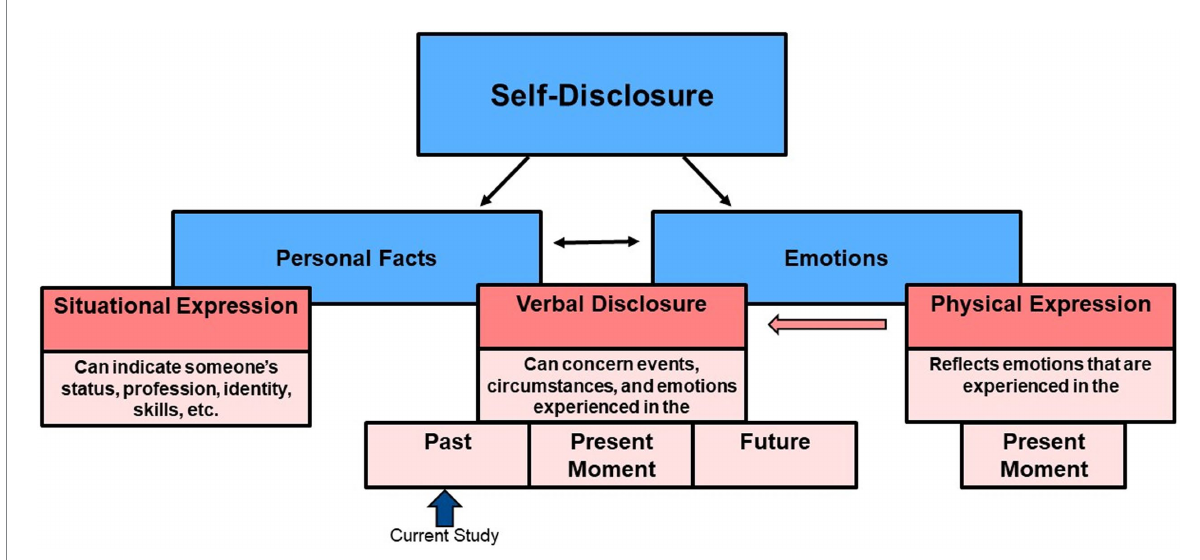
FIGURE 1 Theoretical Framework. Self-disclosure may involve disclosing emotions and/or personal facts about oneself. In the case of emotions, self- disclosure may occur verbally (e.g., “I feel angry”) or through bodily expressions (e.g., shouting, subtle facial expressions). Personal facts (e.g., autobiographical information) are typically communicated verbally or can be situationally expressed (e.g., through clothes or behavior). One can disclose emotions and personal facts with regards to the past (“When we won the basketball game, I felt very happy”), the present (“When I look at my to-do list, I feel annoyed”), or the future (“I anticipate feeling wonderful when I’ll get married”). The processes of disclosing personal facts and disclosing emotions are often intermingled. For example, certain personal facts may appear to imply specific emotions (e.g., disclosing a loved one’s death typically implies sadness). Nevertheless, reporting a personal fact or event is distinct from explicitly stating how that fact or event makes a person feel. Here, we specifically study the effects of explicit, verbal (written) disclosure of emotions alongside personal facts, when compared to disclosing personal facts alone. The current study assesses self-disclosure of emotions and facts relating to the past rather than the present or the